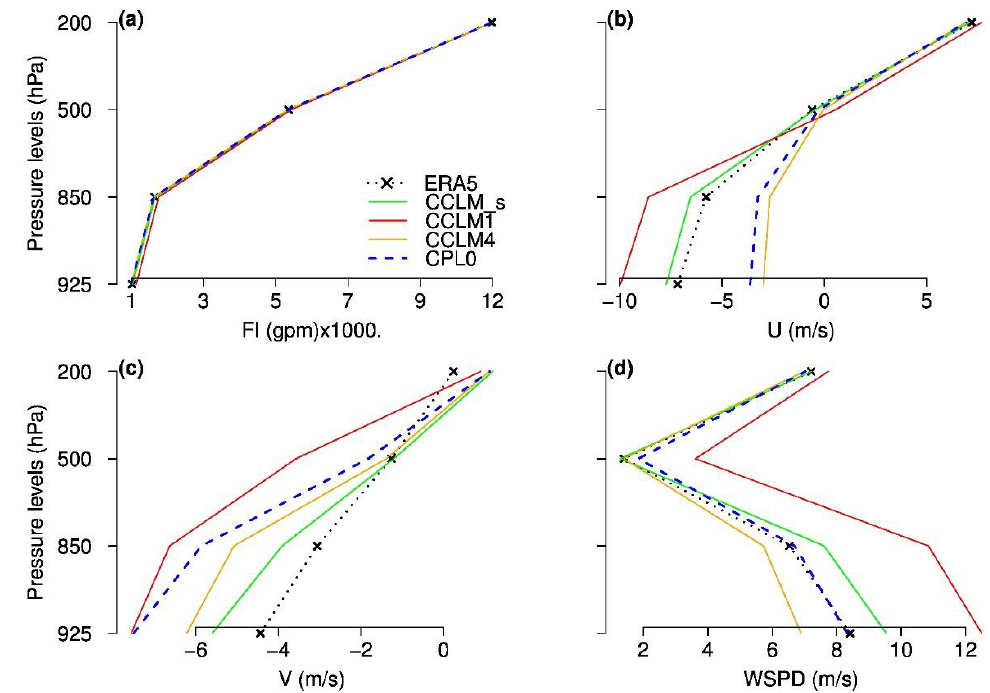
Figure 7. Simulated profiles of daily mean ( a ) geopotential height FI (gpm), ( b ) U (m / s), ( c ) V (m / s) wind components and ( d ) wind speed WSPD (m / s) averaged over the NwgSea area on 28 October 2013.